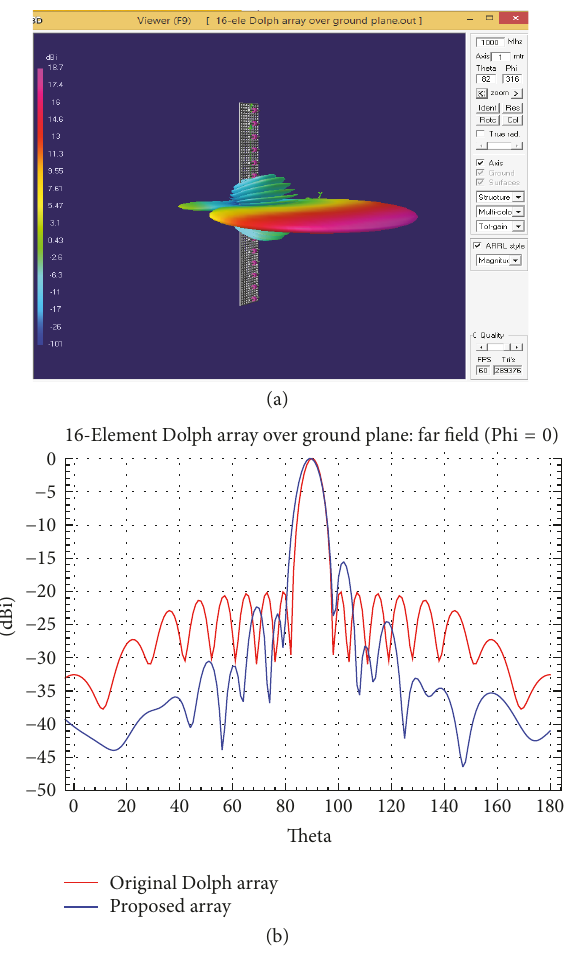
Figure 7: (a) Configuration of an array with 16 dipoles over ground plane. (b) Radiation patterns of the original Dolph pattern and the proposed arrays. Center frequency =